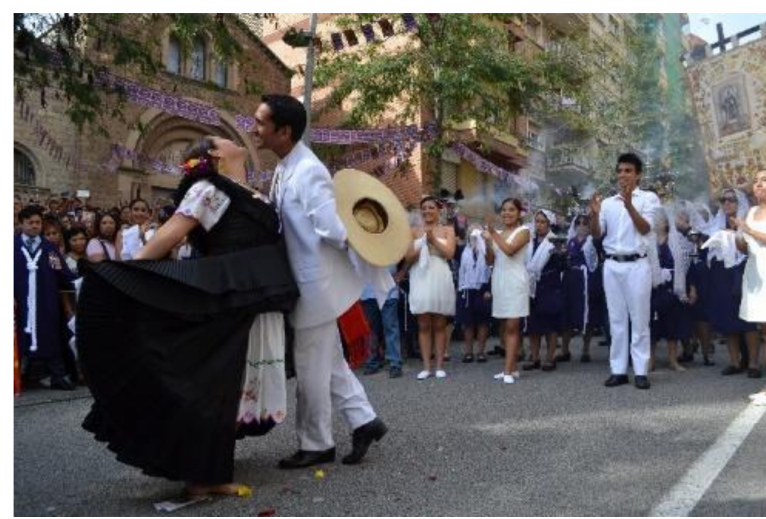
Figure 2. Dancing the Marinera at the front door of the Church, October